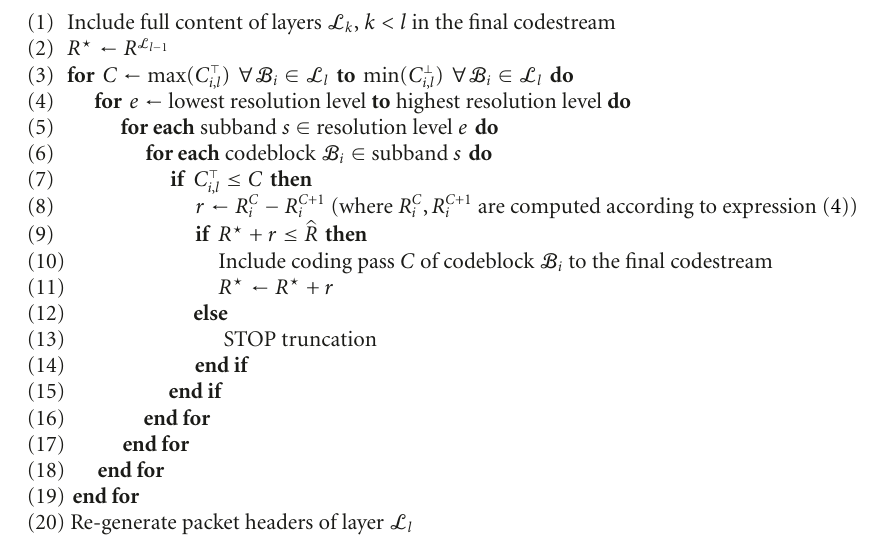
Algorithm 1: Procedure carried out by the Block-Wise Layer Truncation